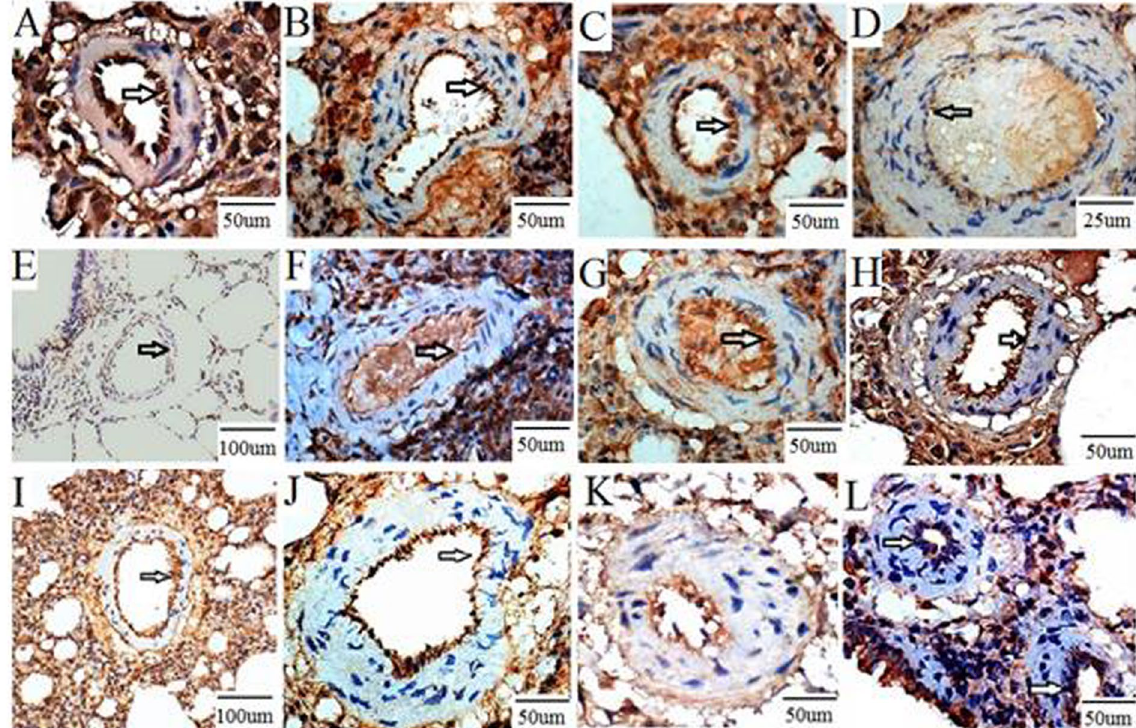
Figure 8. Immunohistochemical staining of FoxO1, Bad, and Bcl-2 in the rat CTEPH model. Note: FoxO1 expression, both nuclear and cytoplasmic, was ‘strong positive’ in all sham subgroups ( A ), ‘positive’ in the 1-week ( B ) and 2-week ( C ) experimental subgroups, and ‘weak positive’ in the 4-week experimental subgroup ( D ). Bad expression, both nuclear and cytoplasmic, was ‘negative’ in all sham subgroups ( E ), ‘positive’ in both the 1-week ( F ) and 2-week ( G ) experimental subgroups, and ‘strong positive’ in the 4-week experimental subgroup ( H ). Bcl-2 expression, both nuclear and cytoplasmic, was ‘positive’ in all sham subgroups ( I ), ‘strong positive’ in the 1-week experimental subgroup ( J ), ‘positive’ in the 2-week experimental subgroup ( K ), and ‘weak positive’ in the 4-week experimental subgroup ( L ).